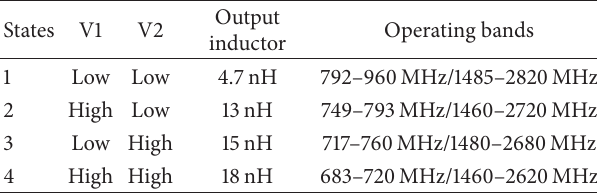
Table 3: The states of RF switch and operating bands.